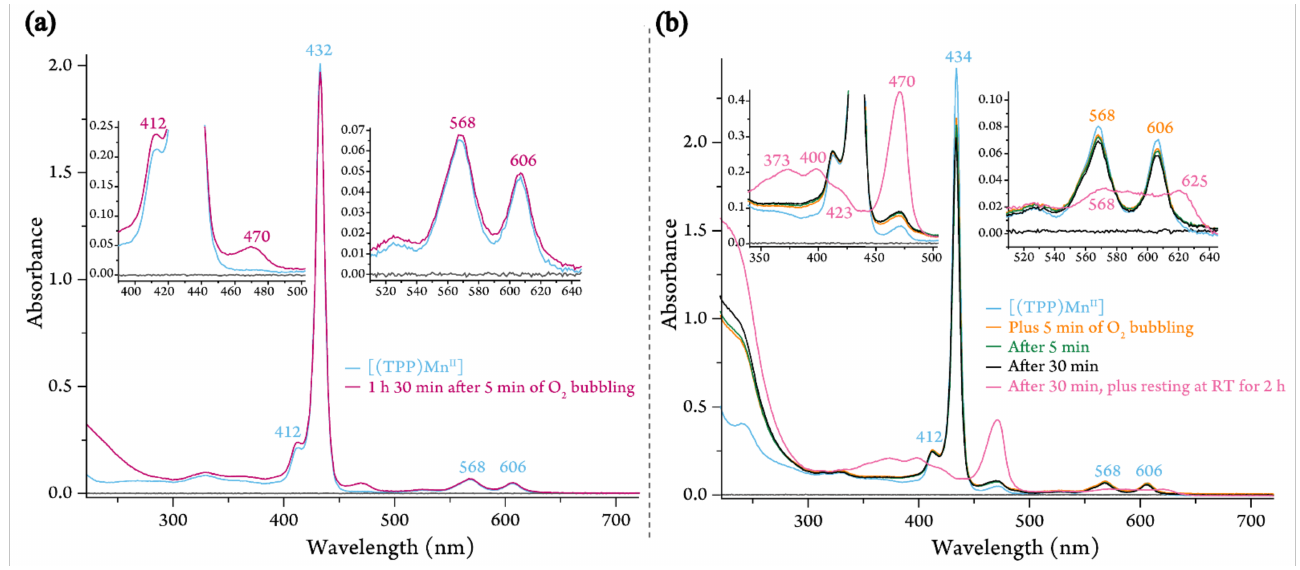
Figure 1. UV-vis spectra of [(TPP)Mn II ] in MeTHF in a 4-mm cuvette upon 5 min of O 2 bubbling at: ( a ) room temperature (10 µ M), and ( b ) − 90 ◦ C (11 µ M). 2.1.2. Dioxygen Chemistry of [(TPP)Mn II ]/[(tmpa)Cu I (MeCN)][B(C 6 F 5 ) 4 ]